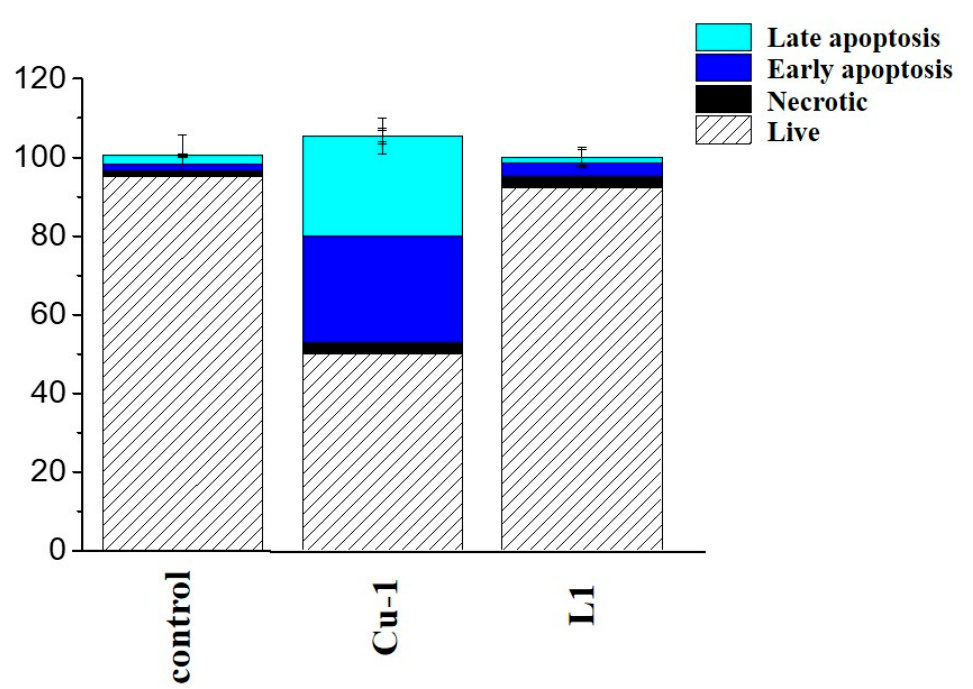
Figure 11. Quantification histograms representing the populations of living, early/late apoptotic and necrotic MCF-7 cells after treatment with Cu-1 and the ligand L1 . Values represent the mean ± standard deviation (SD) of cell population obtained in two independent experiments.